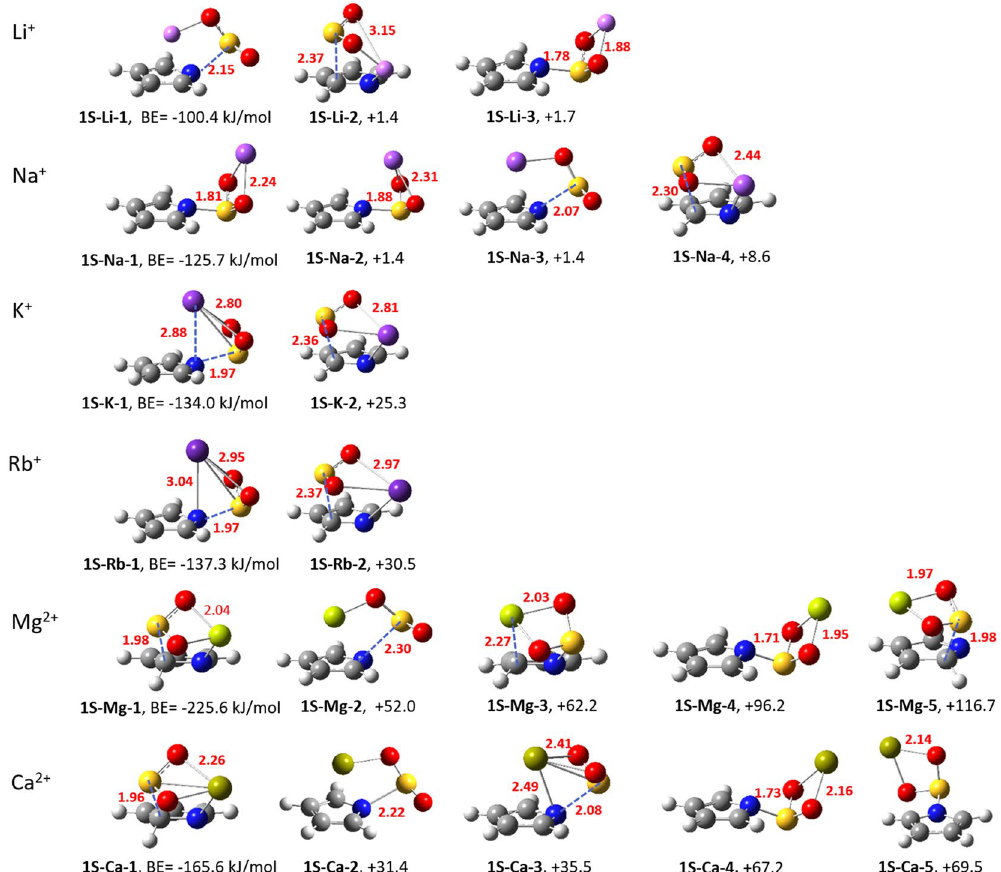
Figure 5. Stable configurations of 1 -cation-SO 2 complexes. The name and the binding energy or the relative binding energy with respect to the most stable one (in kJ mol − 1 ) are given below each configuration. Solid and dashed lines indicate the key bonds and distances of interest (in Å), respectively. Red is oxygen, blue is nitrogen, yellow is sulfur, gray is carbon, white is hydrogen, four light to dark purples are monovalent cations (Li + , Na + , K + and Rb + ) and two yellow-green are divalent cations (Mg 2 + and Ca 2 +